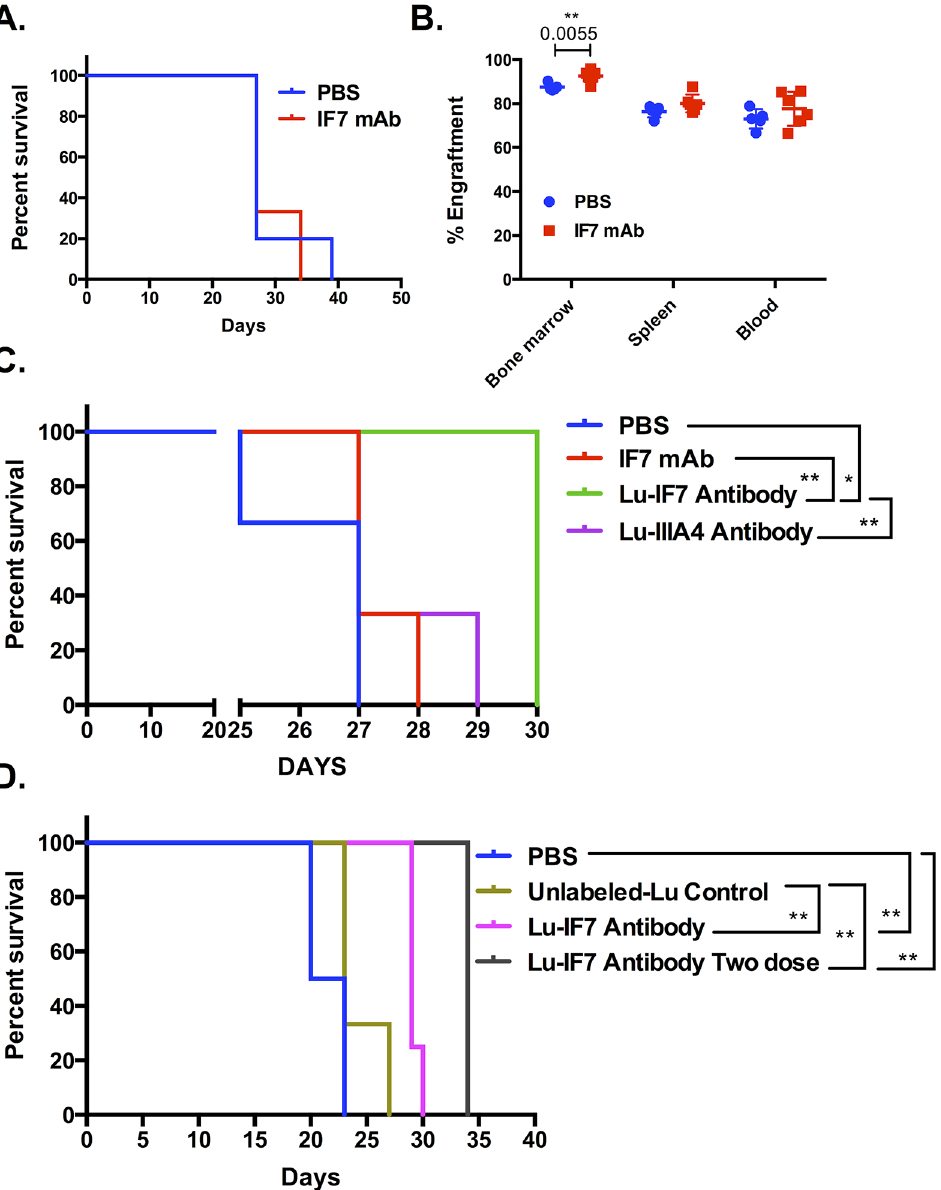
Fig 7. Survival and engraftment data from MLL-AF9 leukemic mice treated with PBS, EphA2 mAb (IF7), radiolabeled EphA2 (Lu-IF7) or radiolabeled EphA3 (Lu-IIIA4) antibody. (A) Survival of MLL-AF9 leukemic mice treated with IF7 mAb or PBS control showed no significant differences between the two groups. (B) Percentage of GFP + cells in bone marrow, spleen and blood showed significantly higher GFP + cells in bone marrow of IF7 mAb treated mice compared to PBS control (P = 0.0055). There were no significant differences observed in spleen and blood of the IF7 treated MLL-AF9 mice compared to wild type control mice at time of cull (n = 5 PBS treated, n = 6 IF7 treated). (C) Survival of MLL-AF9 leukemic mice treated with PBS, IF7 mAb, Lu-IIIA4 or Lu-IF7 antibody. While there were no significant differences between PBS, IF7 and Lu-IIIA4 antibody treated groups, a significant increase in the survival of Lu-IF7 mAb treated group was observed compared to PBS (P = 0.0140), IF7 mAb (P = 0.0100) and Lu-IIIA4 mAb (P = 0.0100) treated group (n = 3 PBS treated, n = 3 IF7 mAb treated, n = 3 Lu-IIIA4 antibody and n = 4 Lu-IF7 treated). (D) Survival of MLL-AF9 leukemic mice treated with PBS, unlabeled-Lu control and Lu-IF7 antibody showed no significant differences between PBS and unlabeled-Lu control antibody treated groups. In contrast there were significant increase in the survival of mice treated with a single dose of Lu-IF7 mAb (P = 0.0084) and more so with two doses of Lu-IF7 (P = 0.0039) compared to PBS control. The increase in survival after treatment with single dose of Lu-IF7 mAb (P = 0.0140) and two doses of Lu-IF7 (P = 0.0046) compared to unlabeled-Lu control (n = 4 PBS treated, n = 3 unlabeled-Lu, n = 4 Lu-IF7 antibody one dose and n = 5 Lu-IF7 antibody two doses, 3 biological replicates). Each dot corresponds to one individual mouse. The data represent mean ± SEM and unpaired t test was performed for statistical analyses. Kaplan-Meir curves were constructed in GraphPad and Log-rank (Mantel-Cox) tests were used to determine statistical differences.